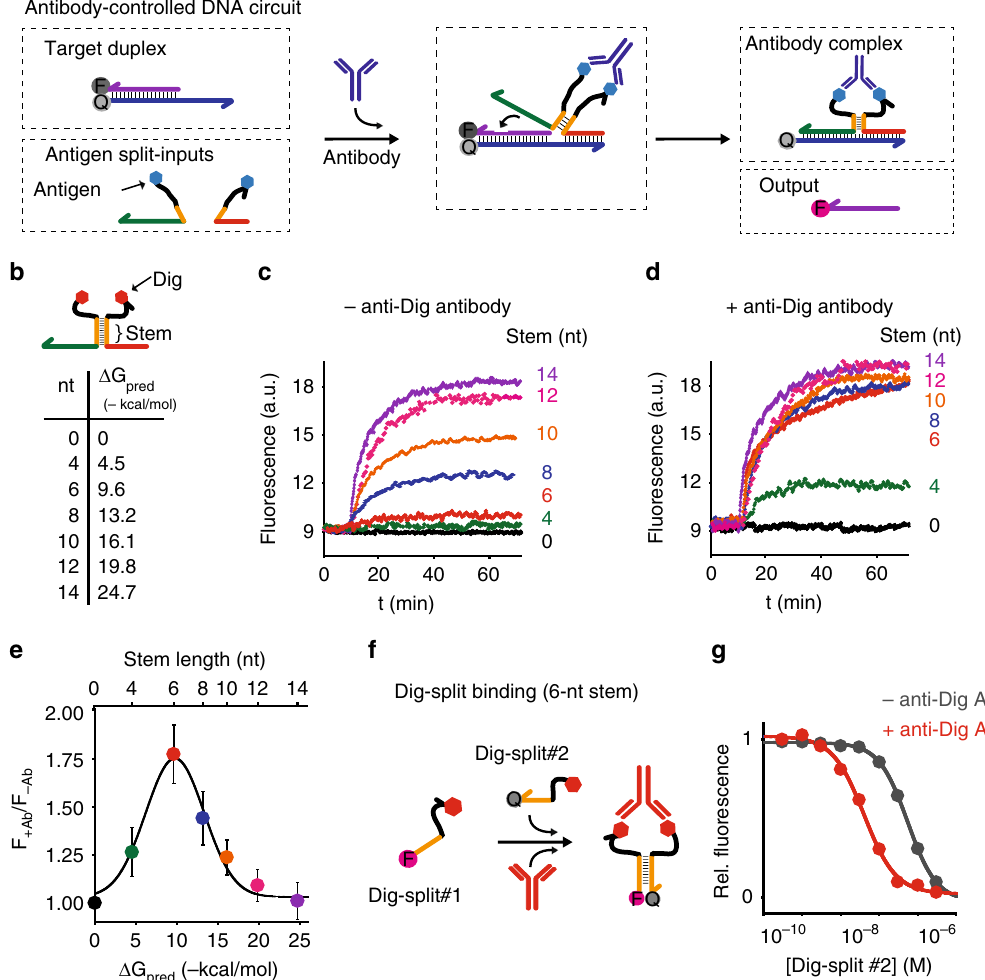
Fig. 1 Principle and optimization of the antibody-controlled DNA circuit. a To engineer a strand displacement reaction controlled by antibody we have split the input strand responsible for the toehold displacement reaction into two portions (red and green) and fl anked them with two complementary portions (orange) and with a 12-nt poly-T tail (black). At the two ends of such tails we have conjugated a molecule (antigen) responsible for antibody recognition. The binding of the antibody to the two antigen-conjugated split-inputs co-localizes them and induces stem formation and reconstitution of the functional input strand. b As a fi rst test-bed we used Digoxigenin (Dig) as the antigen. We tested different stem lengths with various predicted Δ G values. c Fluorescent kinetic traces of strand displacement reactions observed by adding one of the Dig-conjugated split-inputs (60 nM) into a solution containing the other Dig-conjugated split-input (60 nM) and the optically-labeled target duplex (30 nM). d The same experiment described in c but in the presence of the speci fi c anti-Dig antibody (300 nM). e Ratio between the end-point fl uorescent values obtained in the presence and absence of the anti-Dig antibody vs. the predicted Δ G values of the different split-inputs employed. f Stem formation experiment performed by adding increasing concentrations of the Dig- conjugated split-input strand modi fi ed with a quencher (BHQ) to a solution containing the other split-input strand modi fi ed with a fl uorophore (FAM) (60 nM) in the absence (gray curve) and presence (red curve) of the anti-Dig antibody (300 nM). The strand displacement experiments in this fi gure were performed using a target duplex labeled with a FRET couple (Cy3-Cy5) so that the displacement reaction can be easily followed through increase of the fl uorescence signal. All experiments were performed in 50 mM Na ′ ends are marked with an 2 HPO 4 , 150 mM NaCl at pH 7.0, 25 °C. In all sketches, the 3 arrow. The experimental values represent averages of three separate measurements and the error bars re fl ect the standard